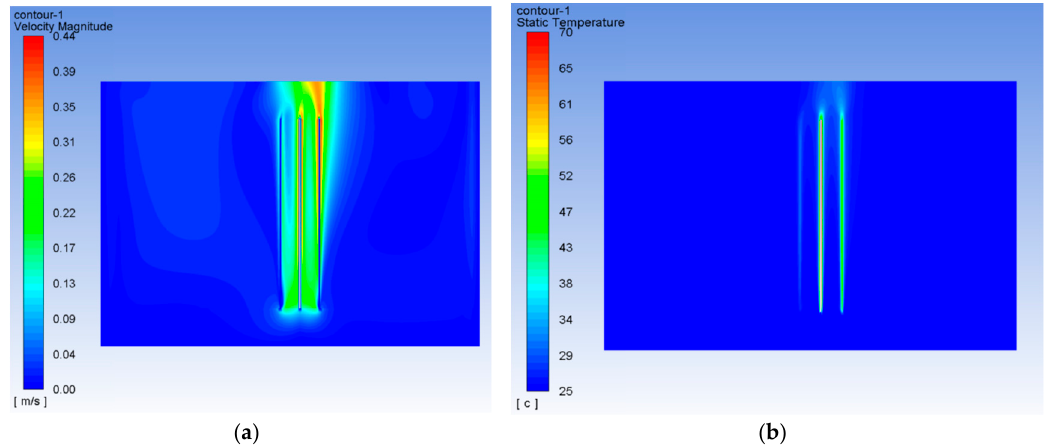
Figure 14. Air velocity distribution ( a ) and temperature distribution ( b ), for the pipe diameter of 200 mm and its length of 1 m [5].